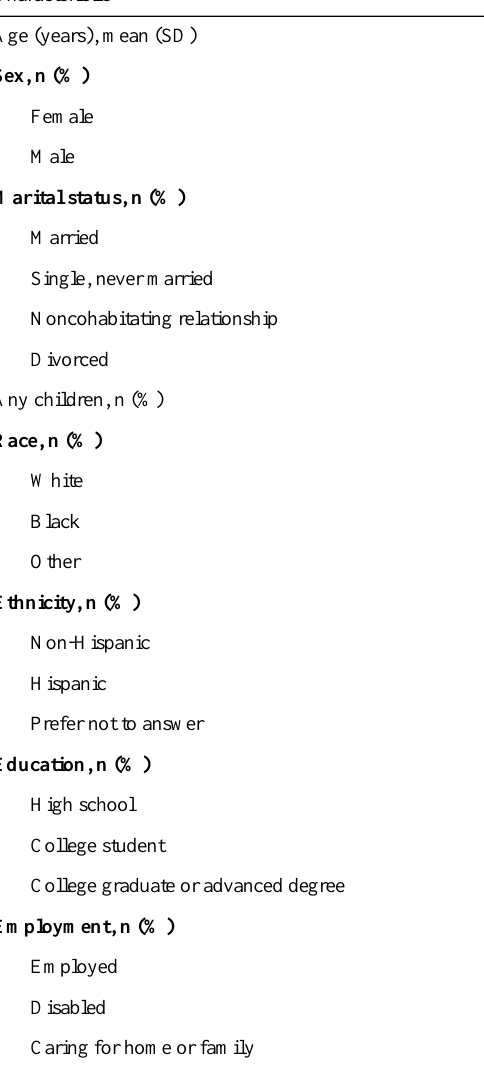
Table 1. Participant characteristics (N=25).